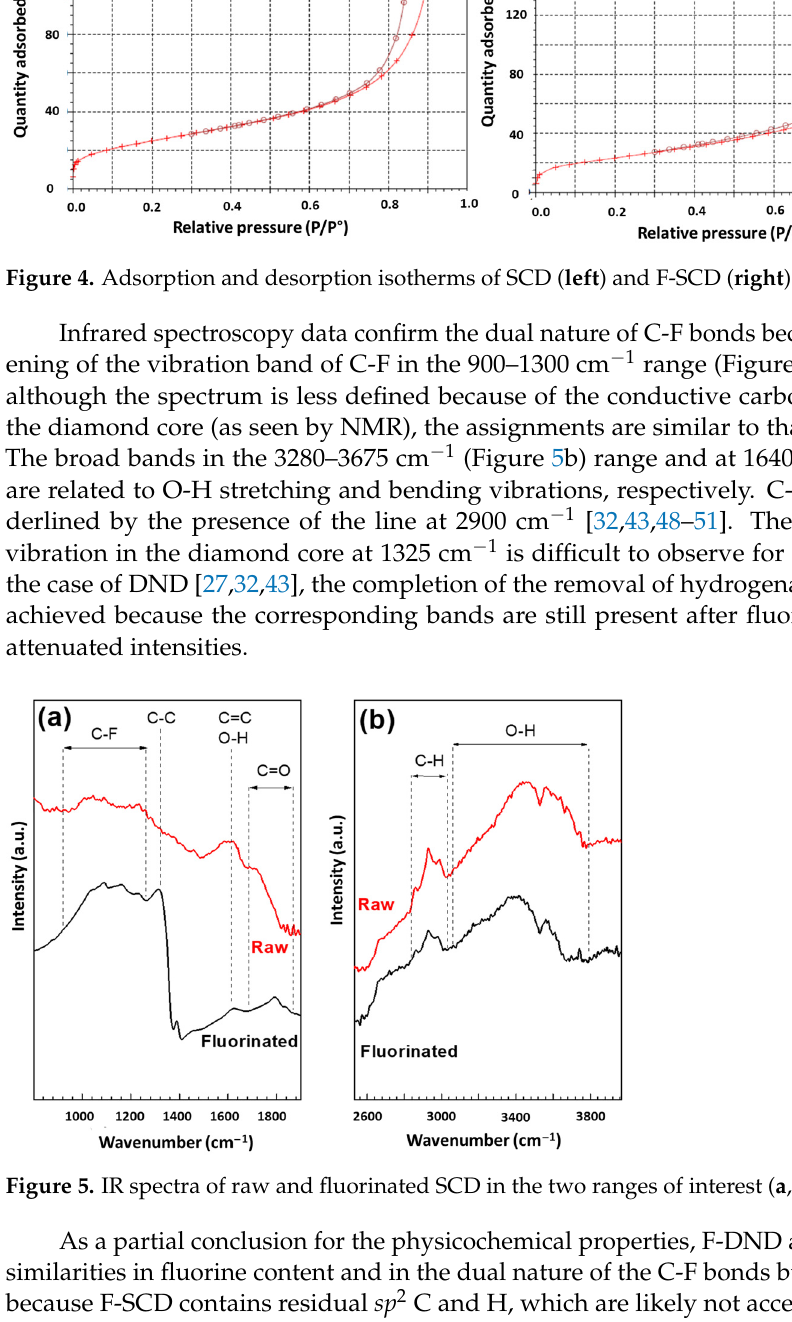
Figure 3. ( a ) 13 C MAS (10 kHz) spectra of raw and fluorinated SCD ( 1 H → 13 C and 19 F → 13 C CP were also used for raw and fluorinated samples); ( b ) 1 H MAS (14 kHz); ( c ) 19 F MAS (14 kHz) spectra.